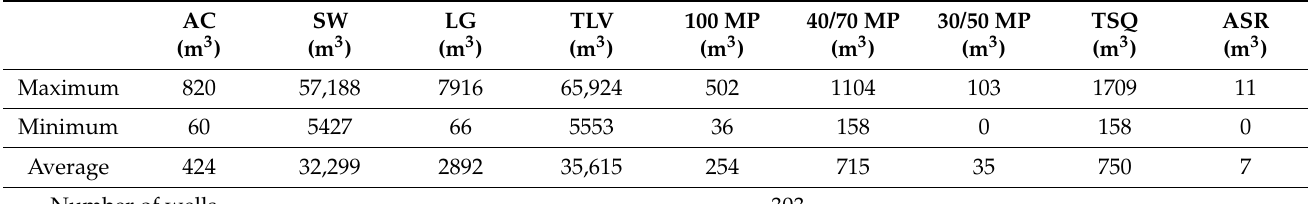
Table 2. Collection of design parameters for the fracturing operation of horizontal